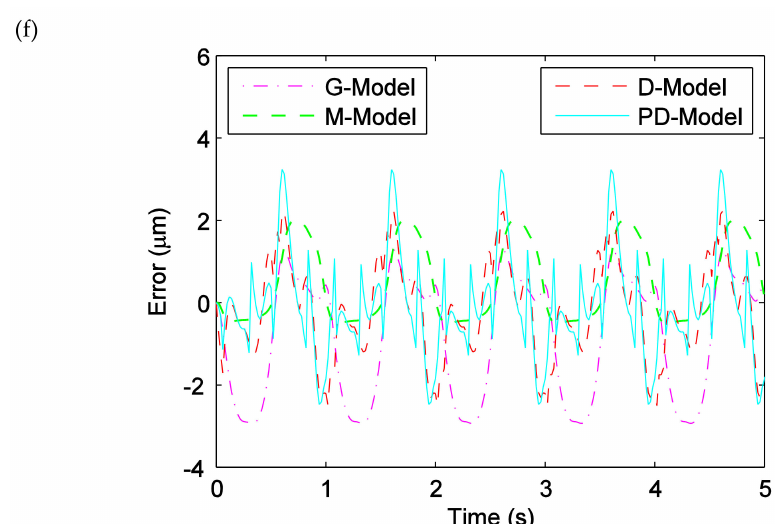
Figure 11. Comparison of the experimental data and the predicted results of the established ISSF-Duhem model and the PD-Model when the magnetostrictive actuator under 1 Hz harmonic input with di ff erent currents: ( a ) the displacement versus current with the current of 1 A, ( b ) the displacement versus time with the current of 1 A, ( c ) the error versus time with the current of 1 A, ( d ) the displacement versus current with the current of 6 A, ( e ) the displacement versus time with the current of 6 A, and ( f ) the error versus time with the current of 6 A. G-Model: the ISSF-Duhem model with Grompertz function-based shape function; M-Model: the ISSF-Duhem model with modified hyperbolic tangent function-based shape function; D-Model: the ISSF-Duhem model with a one-sided dead-zone operator-based shape function; PD-Model: the modified Prandtl–Ishlinskii model with a one-sided dead-zone operator.